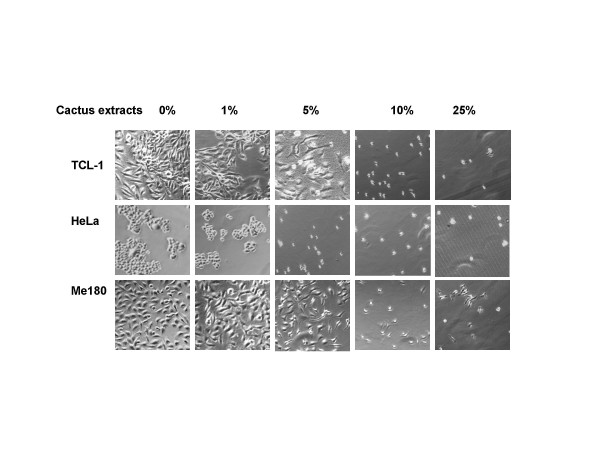
Effect of cactus pear extracts on the morphology of cervical cells. Immortalized cervical cells and cervical cancer cells were grown in the absence (control) or presence of different concentrations of cactus extracts. The photographs were taken on day 3 after the removal of medium containing floating cells.